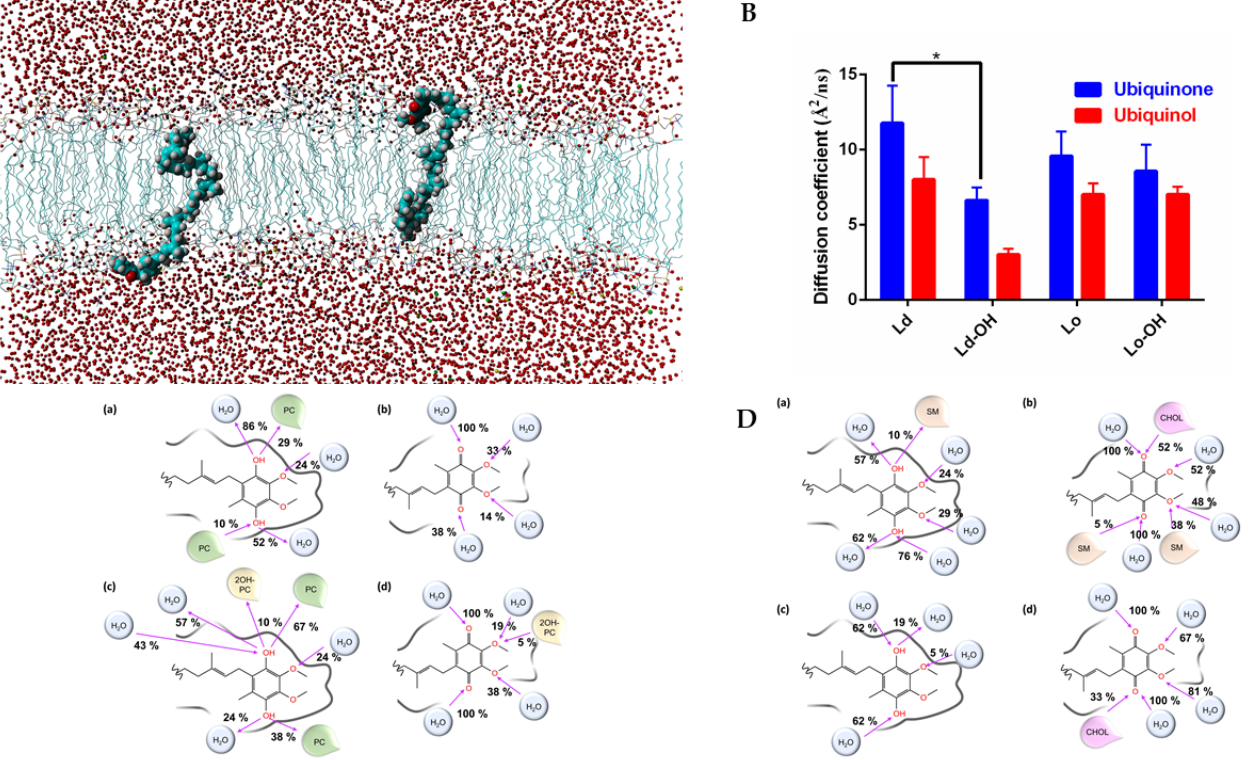
Figure 3. ( A ) Snapshot of the ubiquinol embedded in a POPC/2OH-POPC fully solvated membrane. ( B ) Diffusion coefficients of ubiquinone and ubiquinol in model Lo and Ld membranes. The (-OH) suffix indicates a partial hydroxylation of the lipid chain. Two-way ANOVA ( n = 3) show significant ( p < 0.0001) differences between the row ( Ld , Ld -OH, Lo , Lo -OH) and column (ubiquinol v ubiquinone) factors. *, Student’s t -test shows significant difference ( p < 0.027) between hydroxylated and non-hysdroxylated lipids in Ld membrane. ( C ) Graphical representation of the hydrogen bonds occurring in the last 10 ns of simulation between the ubiquinol ( a , c ) or ubiquinone ( b , d ) and the water/membrane system. In ( a , b ), we simulated the ubiquinol and ubiquinone embedded in a pure POPC membrane (the lipids were indicated in green as PC). In ( c , d ), we simulated the ubiquinol and ubiquinone embedded in a membrane model POPC/2OH-POPC (50%–50%). The hydroxylated POPC was indicated as 2OH-PC and colored in yellow. The pink arrow indicates whether the oxygen atom is an acceptor or donor of hydrogen bonds. Interactions with a frequency lower than 5% were not shown. ( D ) Same as in ( C ), but in ( a , b ) we simulated the ubiquinol and ubiquinone embedded in a membrane model SM/CHOL (60%–40%). The SM lipids were indicated as SM and colored in light orange. The cholesterol was indicated as CHOL and colored in pink. In ( c , d ) we simulated the ubiquinol and ubiquinone embedded in a membrane model SM/2OH-SM/CHOL (30%–30%–40%). The pink arrow indicates whether the oxygen atom is an acceptor or donor of hydrogen bonds. Interactions with a frequency lower than 5% were not shown. The hydroxylated form of SM shows no relevant interactions with